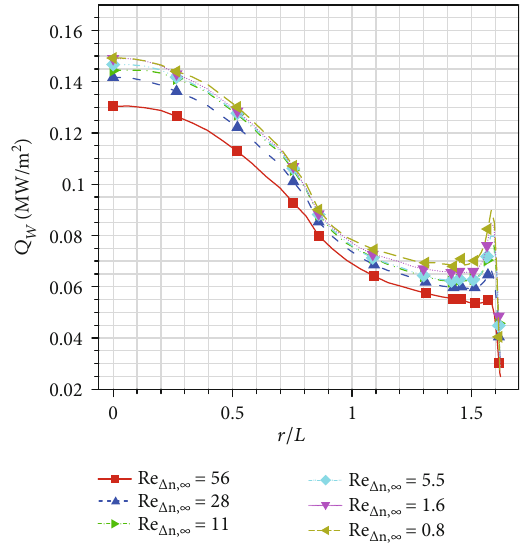
Figure 6: Heat fl ux distributions under di ff erent normal grid spacing at the wall.